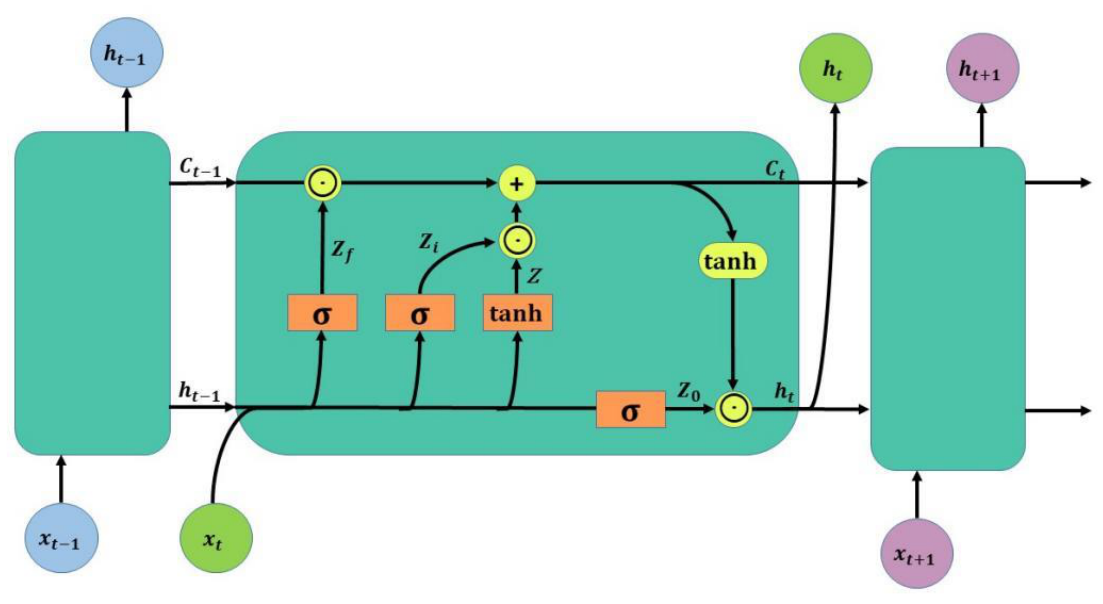
Figure 3. Structure of Figure 3. structure of LSTM.